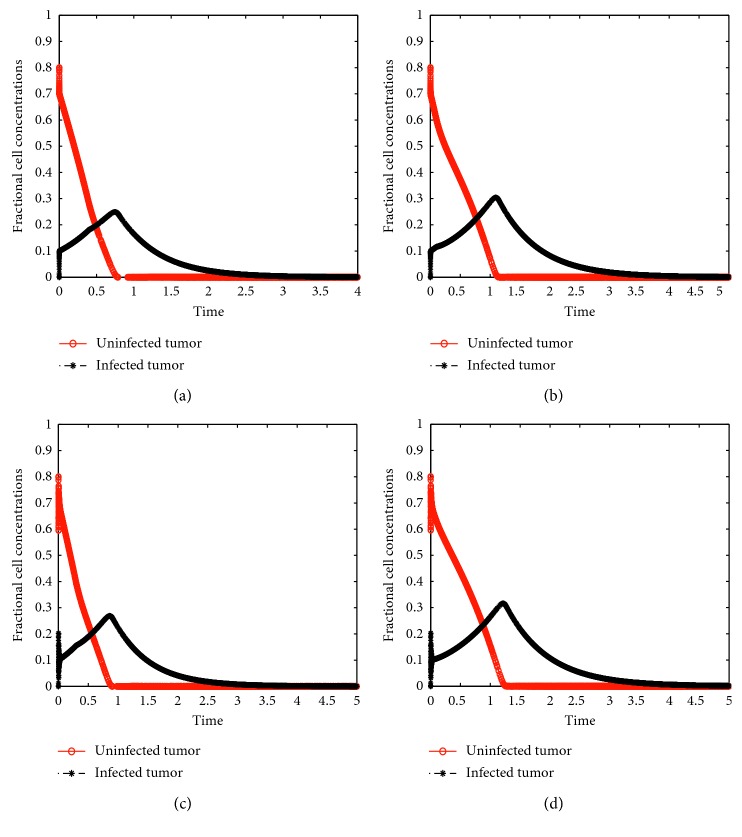
Solutions of delay model (15) showing a variation of fractional concentrations with time using (a) τ
1=0.001, τ
2=0.1; (b) τ
1=0.01, τ
2=0.1; (c) τ
1=0.001, τ
2=0.001; and (d) τ
1=0.001, τ
2=0.3.